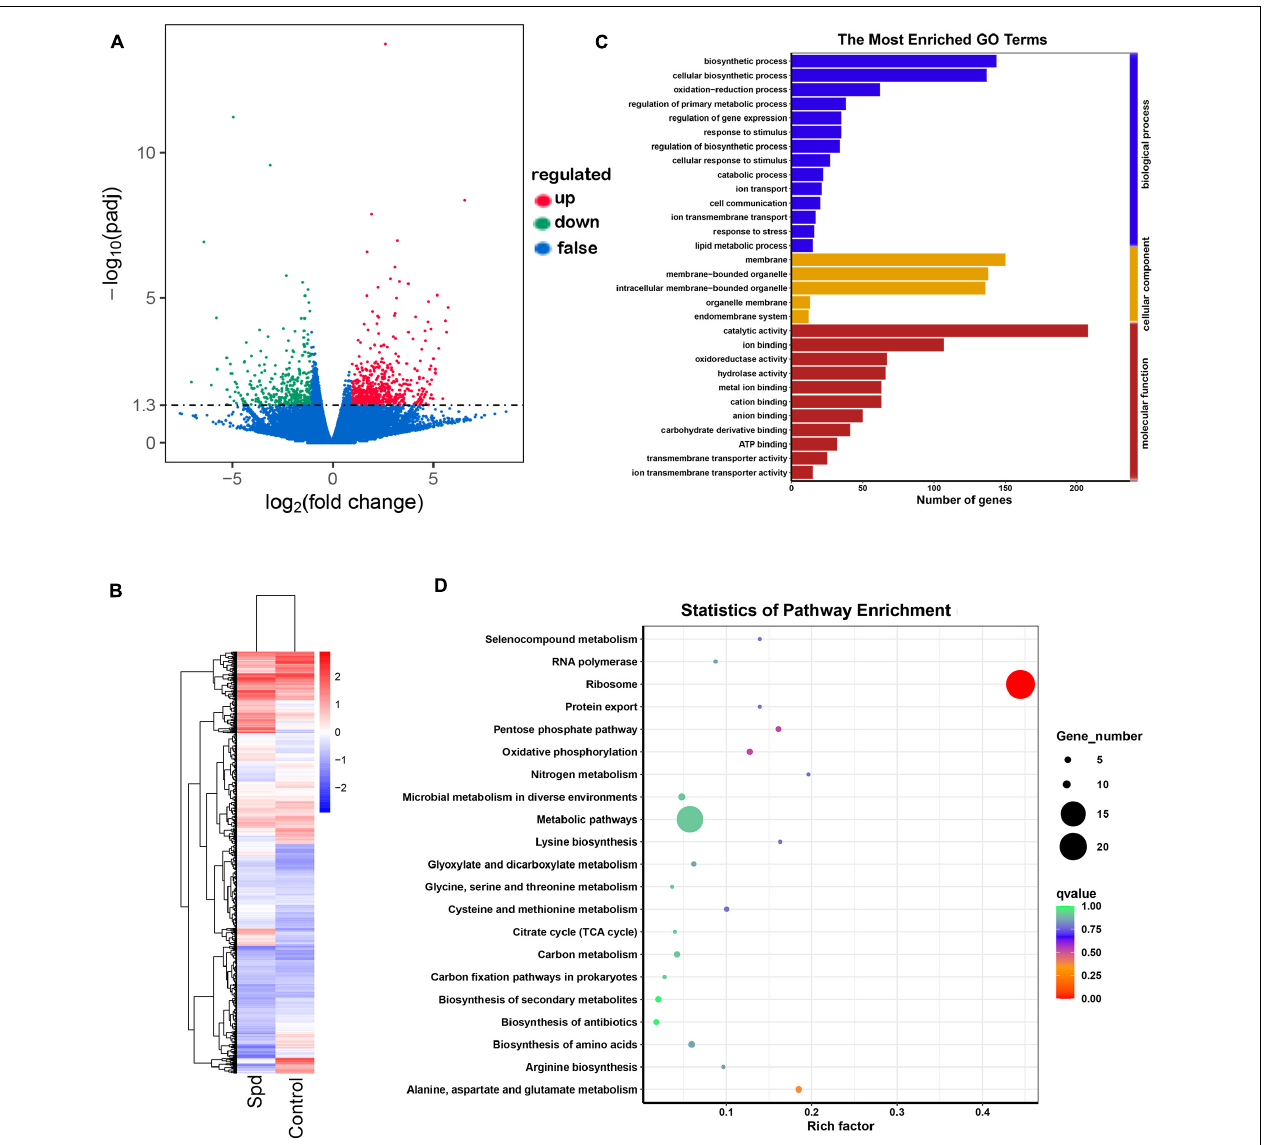
FIGURE 7 | Spd priming altered the enrichment profiles of differentially expressed genes. (A) Volcano distributions of DEGs. (B) Cluster analysis of differentially expressed genes. (C) The GO terms of DEGs. (D) Statistics of pathway enrichment of differential genes. DEGs, differentially expressed genes; GO, gene